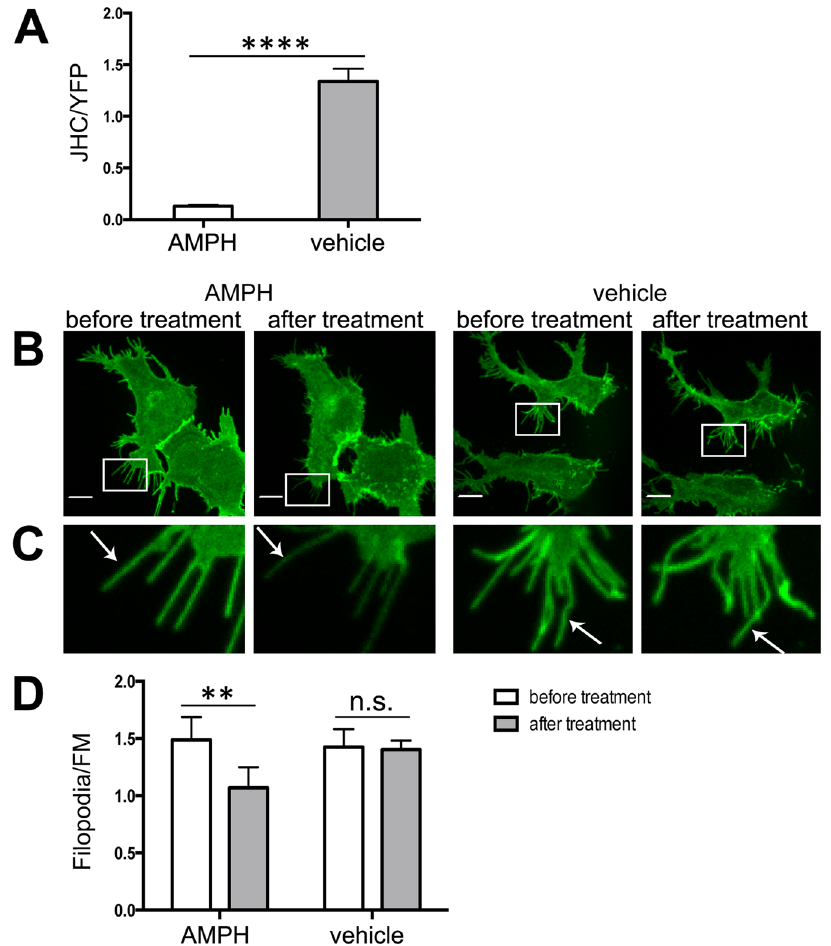
Figure 8. AMPH treatment reduces the concentration of wt DAT in the filopodia of HEK293 cells. ( A ) Cells transiently expressing YFP-HA-DAT were treated with AMPH or vehicle (control) at 37°C for 1 hr. Cells were then incubated with 100 nM JHC1-64 for 10 min. Images were acquired through 515 nm (YFP, green) and 561 nm (JHC1-64, red) filter channels. The ratio of JHC1-64 and YFP fluorescence intensities (JHC/YFP) was calculated for individual cells. Results are shown as mean ± SEM, n = 5. **** p < 0.0001. ( B ) Cells transiently expressing YFP-HA-DAT were incubated with 10 μ M AMPH or vehicle in KRH at 37 °C for 30 min. Live-cell imaging was performed through 515 nm (YFP, green) filter channel. Maximal z-projections of 5 consecutive x-y-confocal planes are shown. Scale bars, 10 μ m. ( C ) Insets represent high magnification images of the regions marked by the white rectangle in ( B ). Arrows point on examples of peripheral filopodia. ( D ) The filopodia/FM ratios of YFP fluorescence intensities were calculated in experiments exemplified in ( B , C ). Results are shown as mean ± SEM, n = 8. ** p <